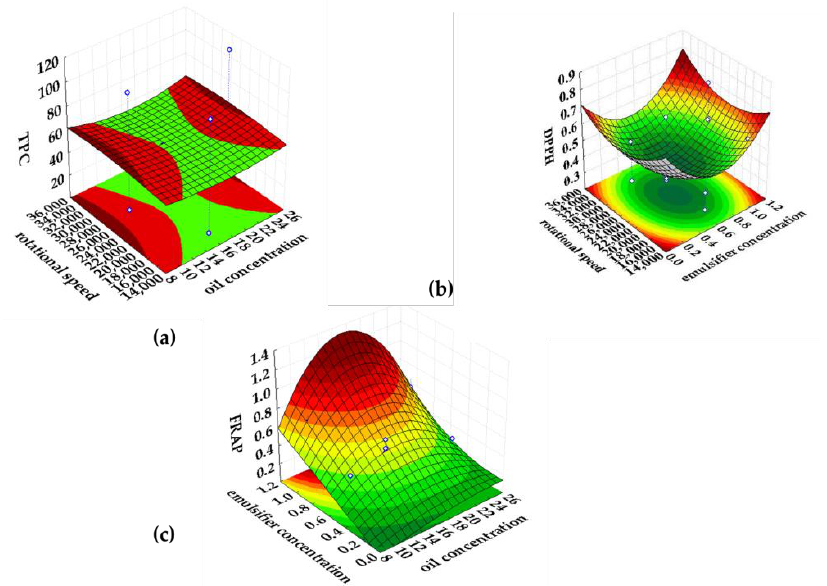
Figure 4. Response surfaces of the significant variables influencing ( a ) the total polyphenolic content (TPC), antioxidant activity determined by ( b ) the DPPH and ( c ) the FRAP for the emulsified oregano extract.